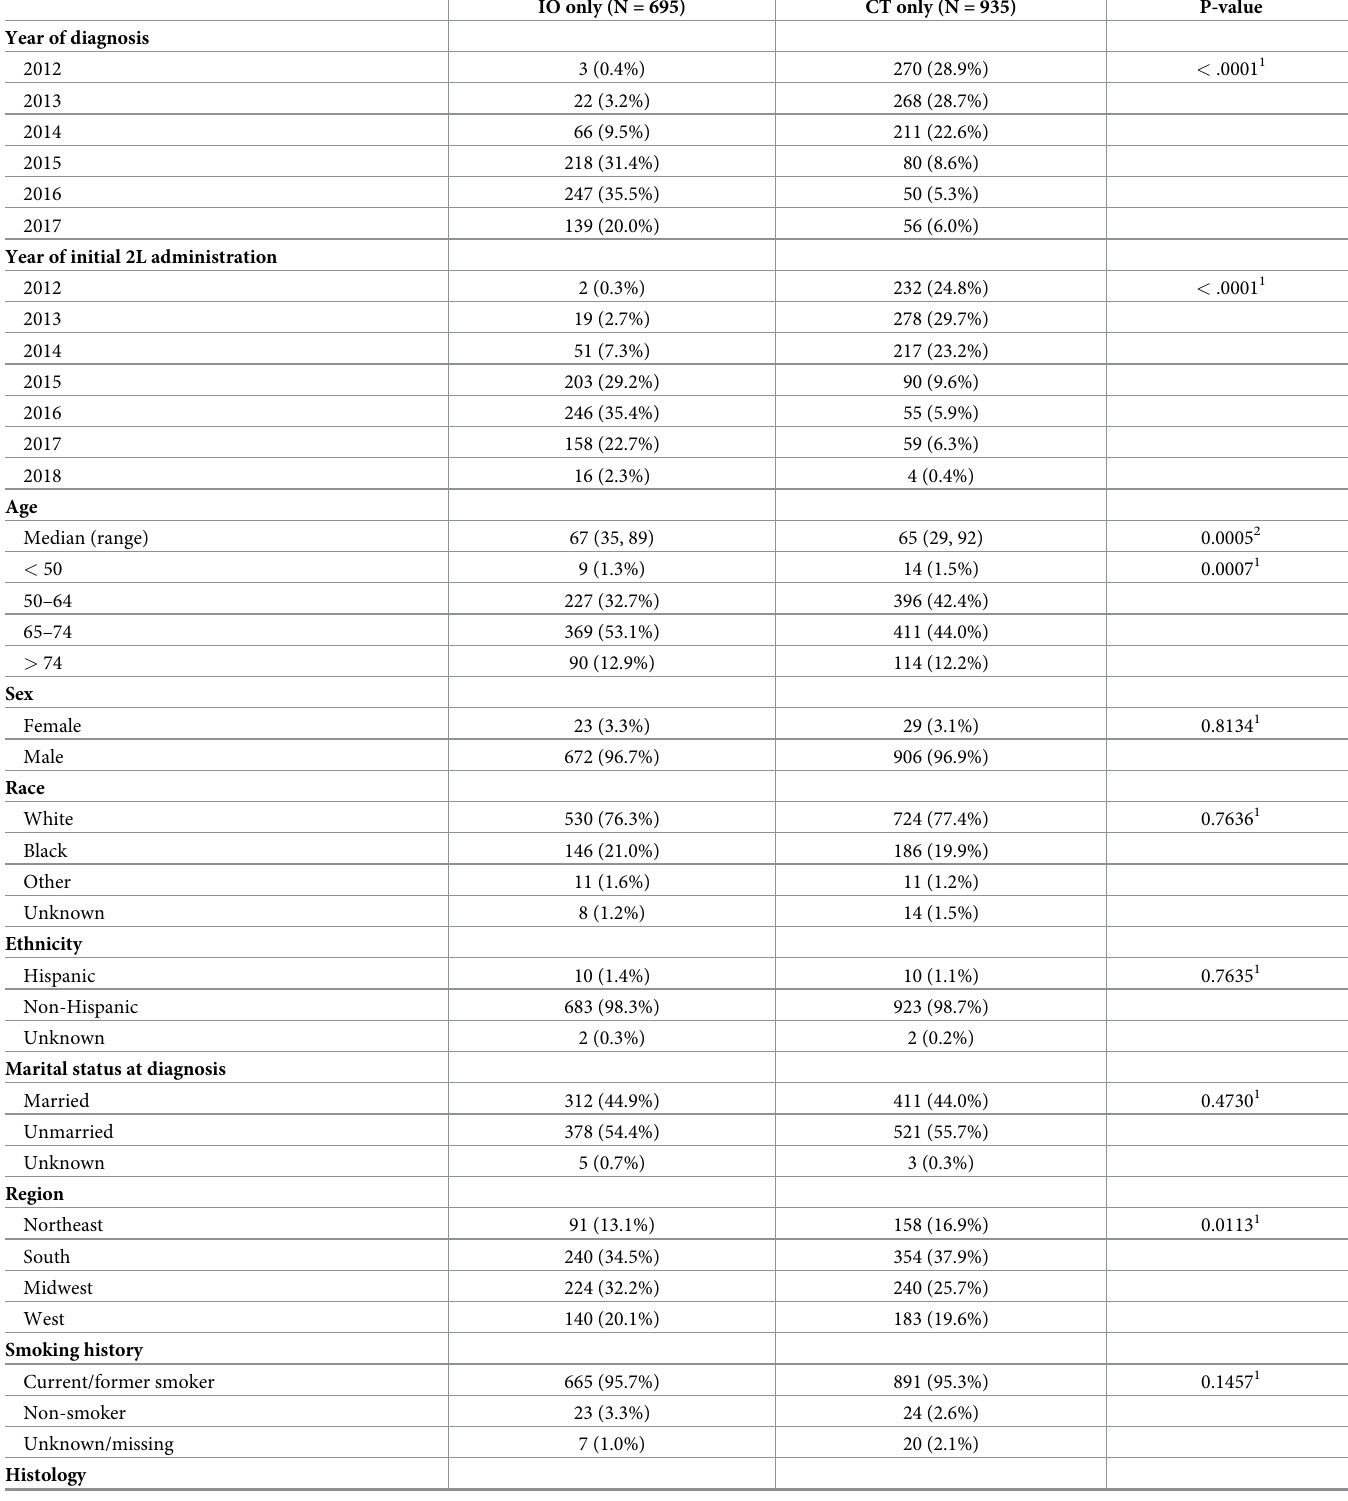
Table 1. Patient demographic and clinical characteristics by 2L